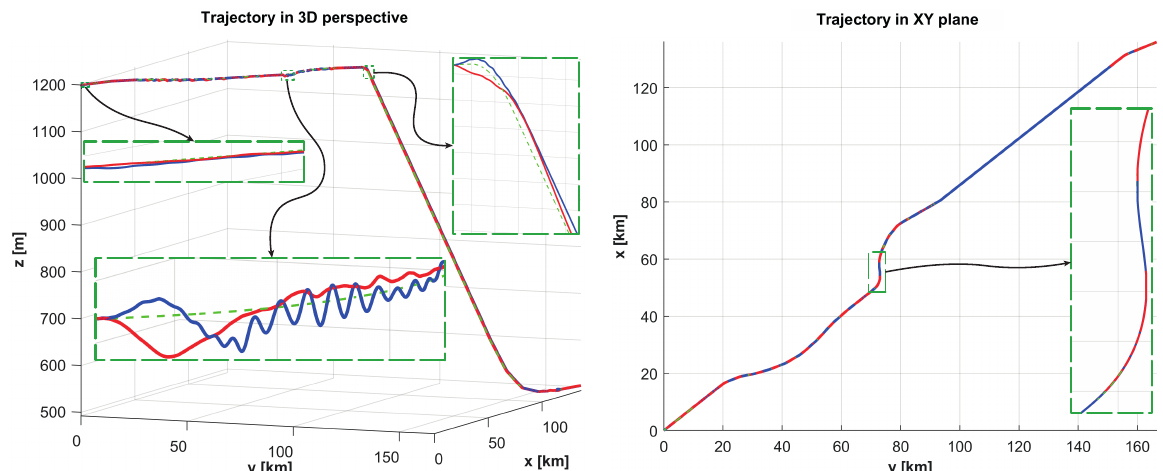
Figure 13. Final trajectory from two perspectives; LQR (blue), MPC (red), and reference path (discontinuous green).